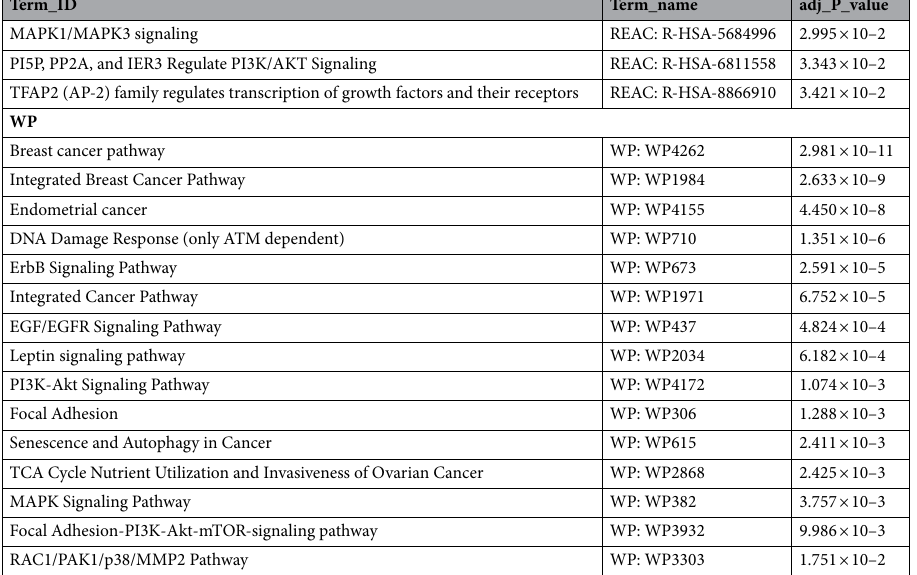
Table 6. Integrative pathway enrichment analysis for DEGs.